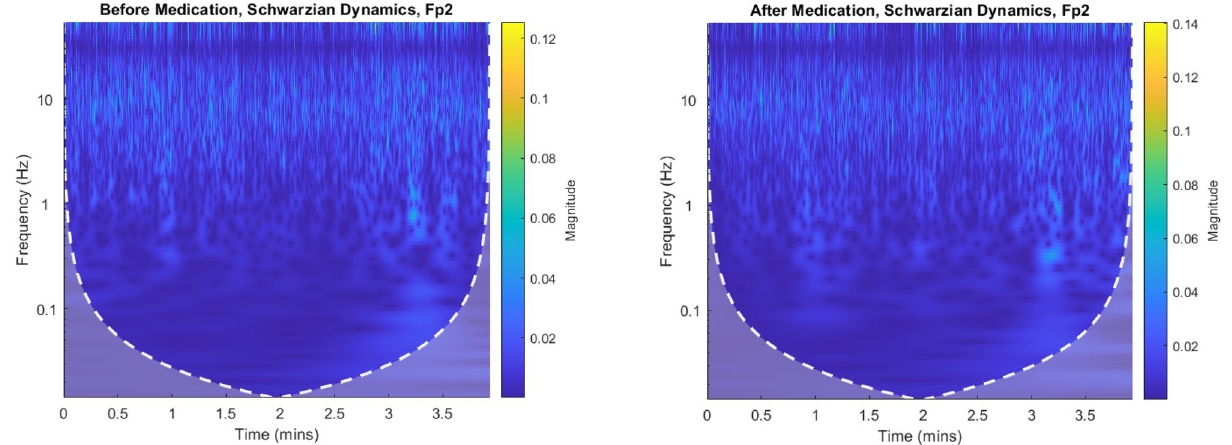
Figure 3. Continuous wavelet transformation of Schwarzian Dynamics (pre-intake and post-intake). Instantaneous frequency transitions in vertical direction are seen clearly.